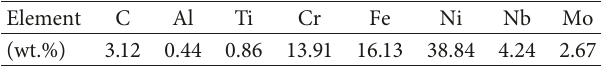
Table 2: ECM experiment conditions.